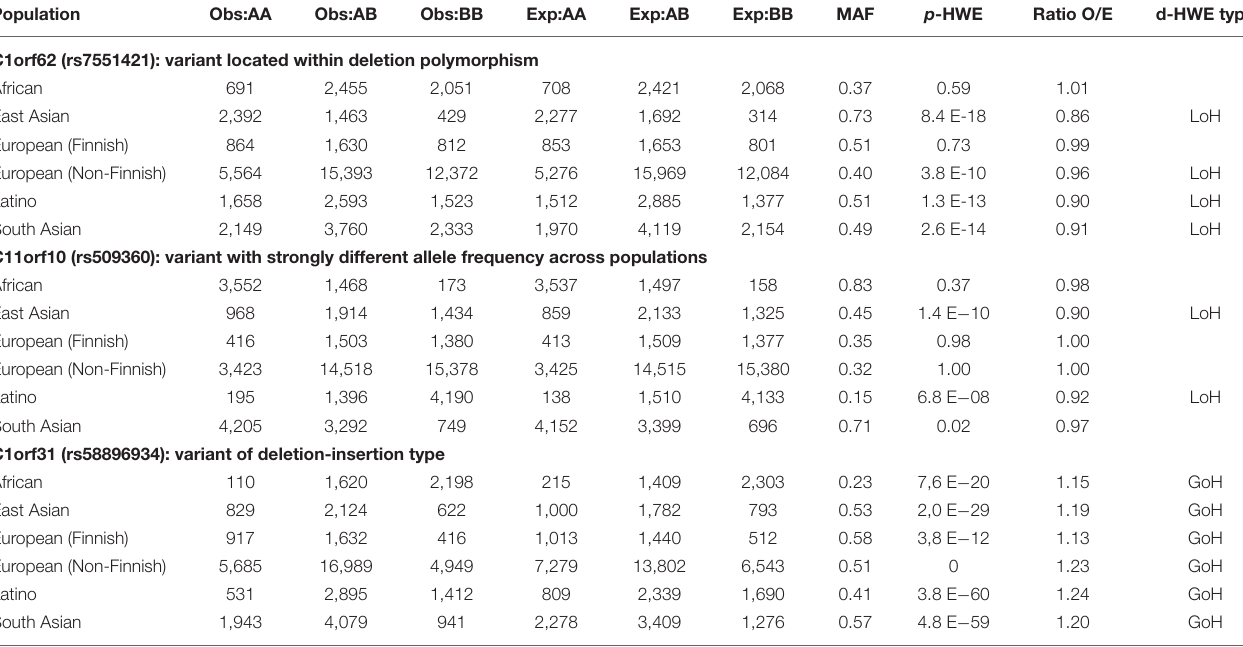
TABLE 2 | Examples of HWE-departure in three ExAC variants.